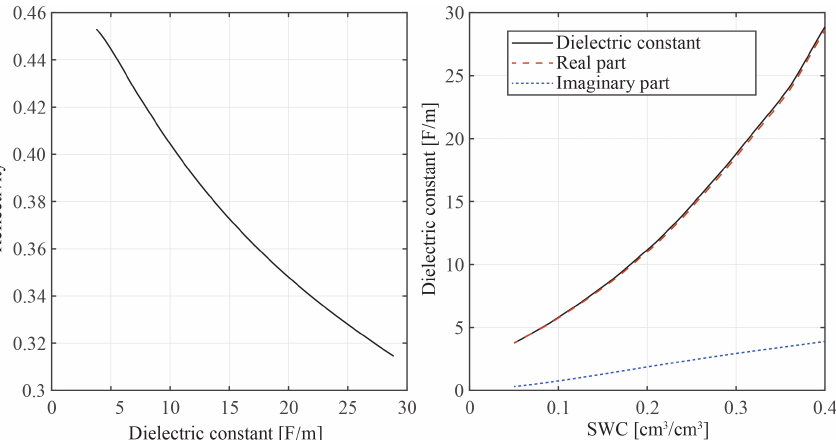
Figure 2. Results of the simulation. The relationship between the RHCP direct reflected signal peak power ratio (reflectivity) and the soil dielectric constant is shown on the left, while the association between soil dielectric constant and SWC is shown on the